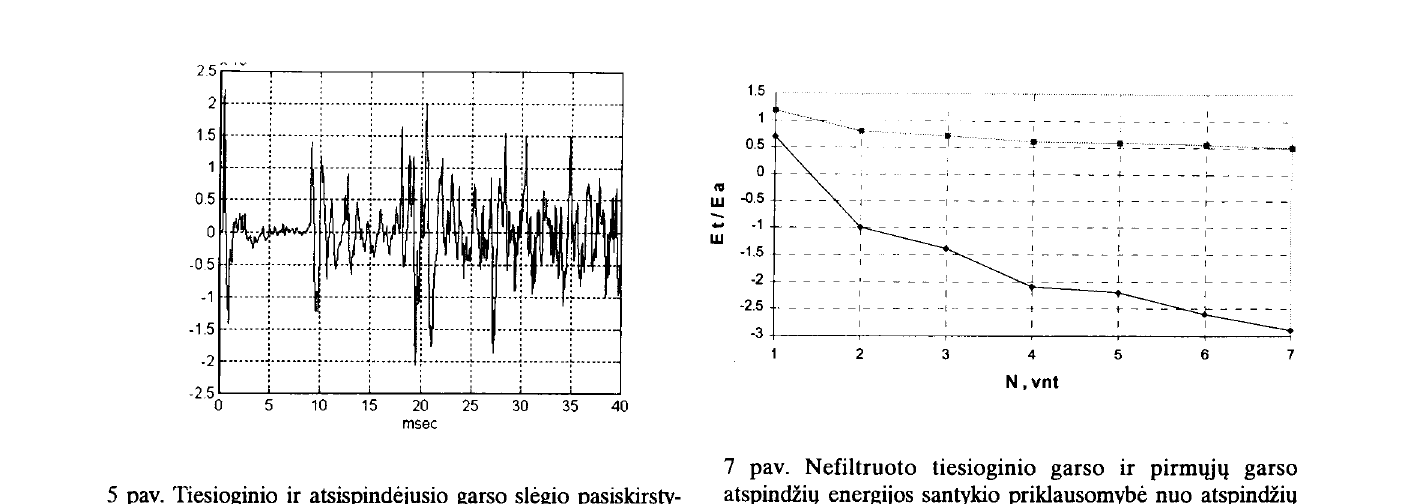
5 pav. Tiesioginio ir atsispindejusio garso sJegio pasiskirsty mas nefiltruotame impulse per pirmas 40 ms. Ta8kas yra 11 m nuo saltinio Fig. 5. The distribution of the direct sound pressure and the reflected sound pressure in the nonfiltered impulse over the first 40 ms. The point is located 11 m from the